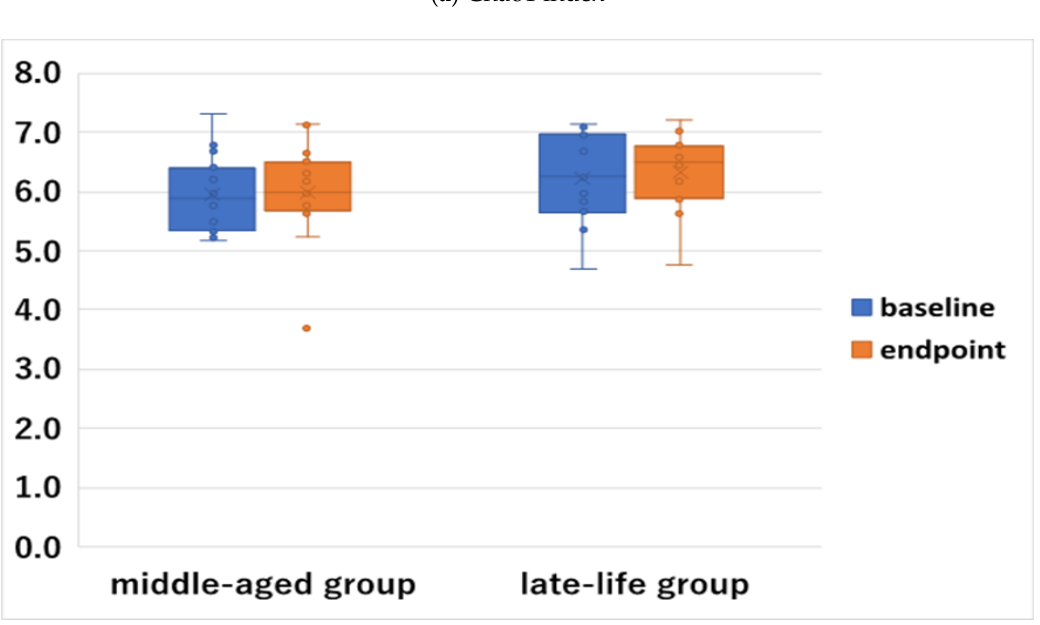
Figure 4. Microbiota alpha diversity between baseline (blue) and endpoint (orange) after the usual treatment in the late-life ( n = 11) and middle-aged ( n = 16) groups; * p < 0.05. Notes: The box signifies the upper (Q3) and lower (Q1) quartiles. The median is represented by a line and the mean by an X within each box. The whiskers extend up from the Q3 quartiles to the maximum data that are less than or equal to 1.5 times the interquartile range (IQR) and down from the Q1 quartile to the minimum data that are larger than 1.5 times the IQR. Values outside this range are considered to be outliers and are represented by dots.